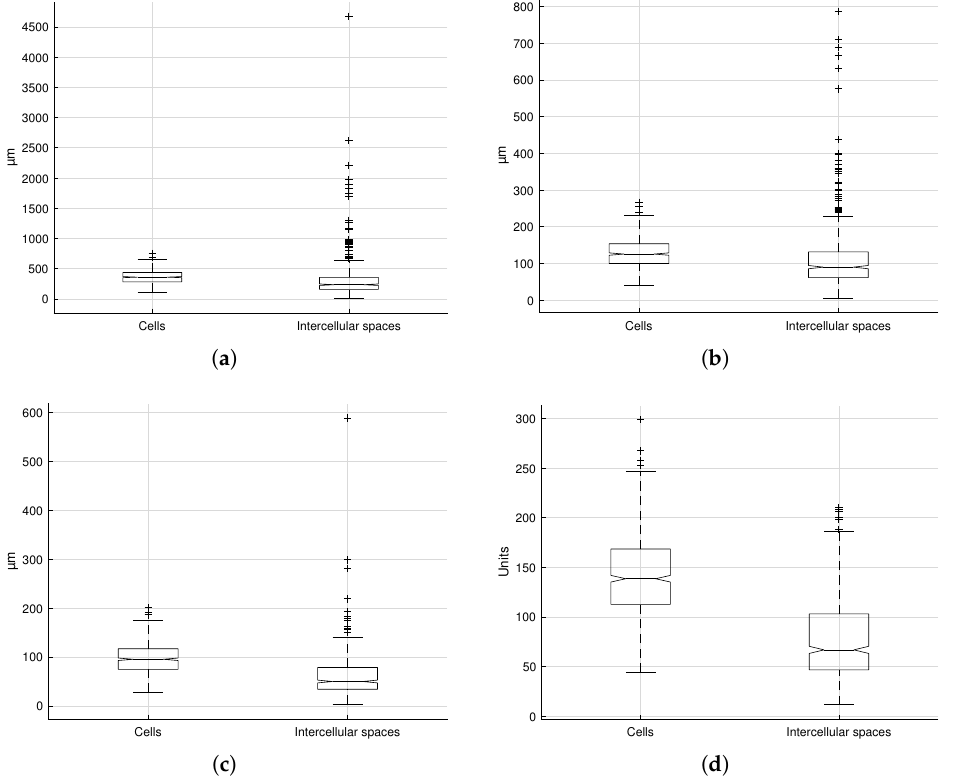
Figure 11. Selected feature values for microstructural elements in the studied sample: ( a ) perimeter, ( b ) length of mayor axis, ( c ) length of minor axis, and ( d ) roundness.